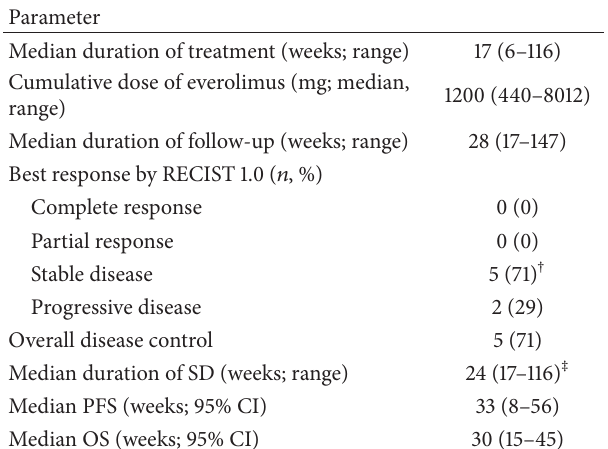
Table 2: Efficacy